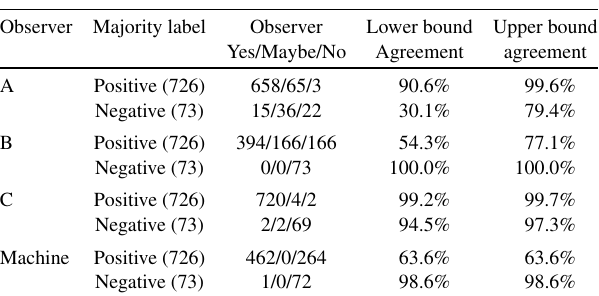
Prediction of test figures where two pathologists